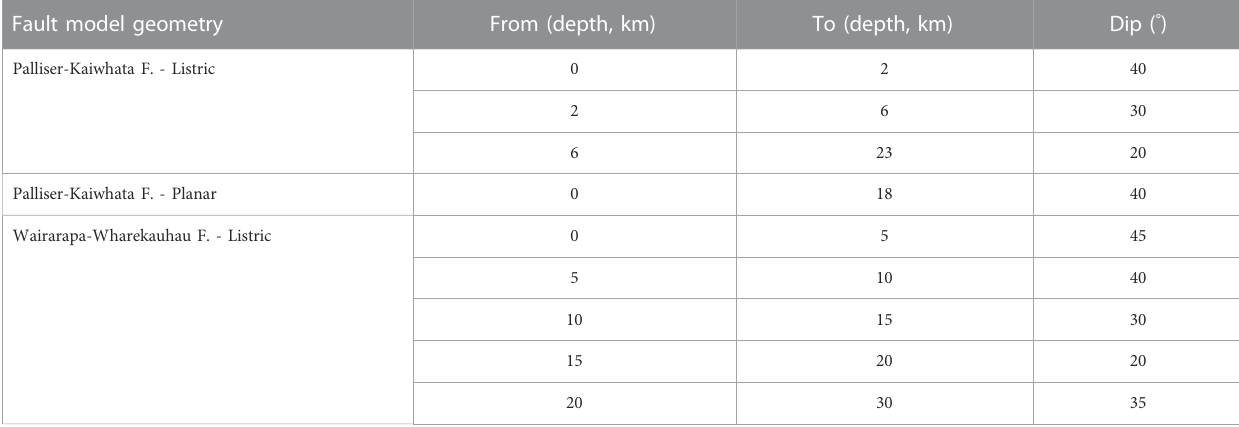
TABLE 3 Fault model geometries for the model scenarios in Table 2. Depths shown are vertically downwards from the surface. Fault model